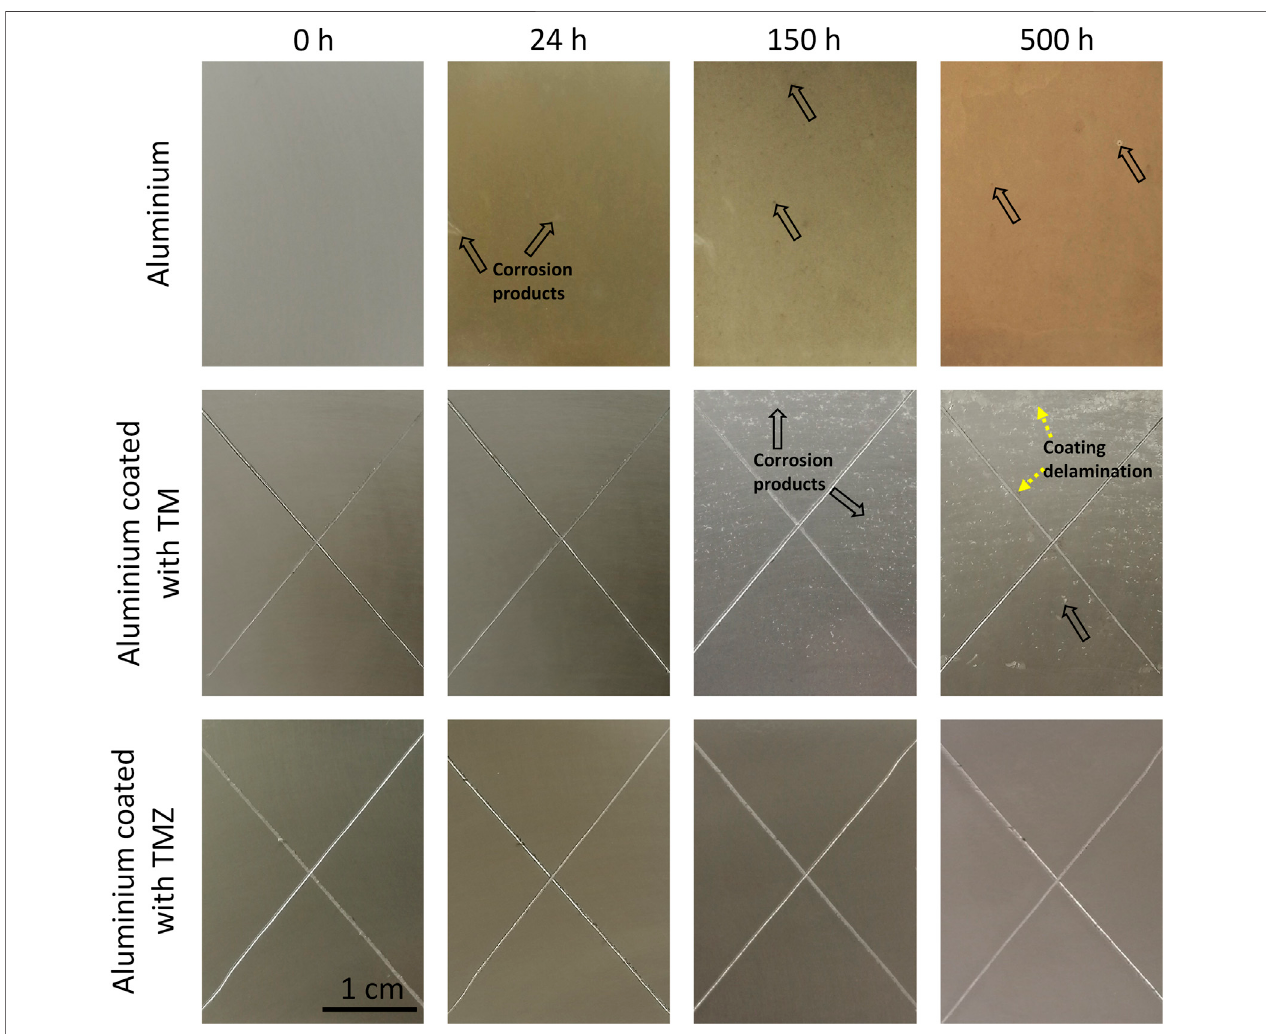
FIGURE 11 | The surface appearance of ground aluminium and coated with TM and TMZ coatings at various exposure times in salt-spray chamber. The arrows mark the spots where corrosion starts on aluminium and aluminium coated with TM. The X-cross scribe was made before exposure to salt spray. Testing was in 5 wt% NaCl at 37 ° C according to the standard ASTM